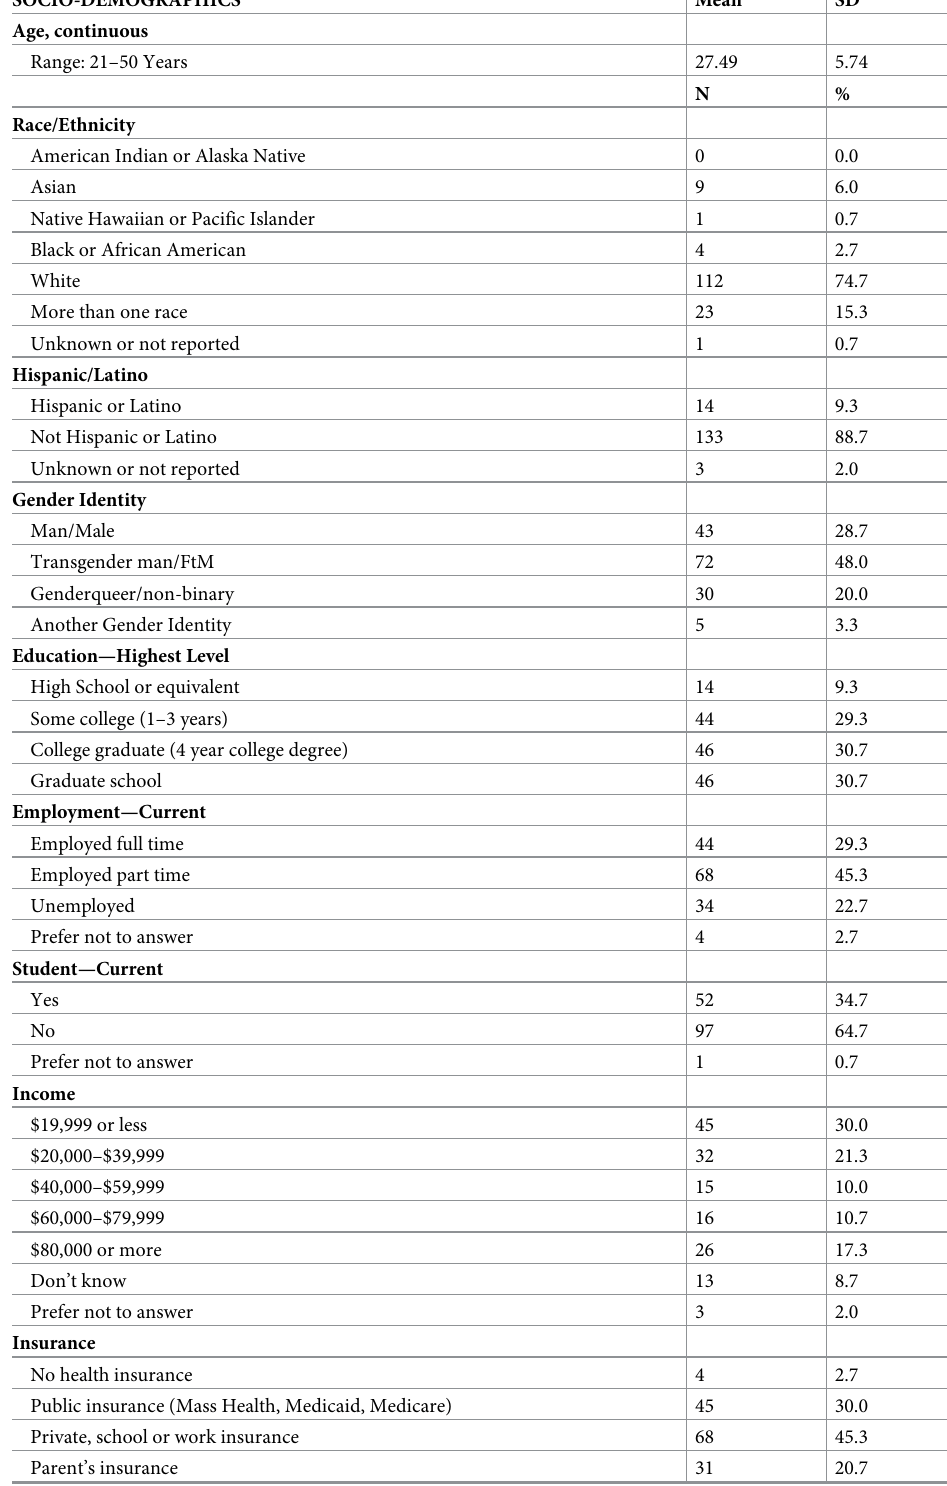
Table 1. Descriptive characteristics of trans masculine sample (N =